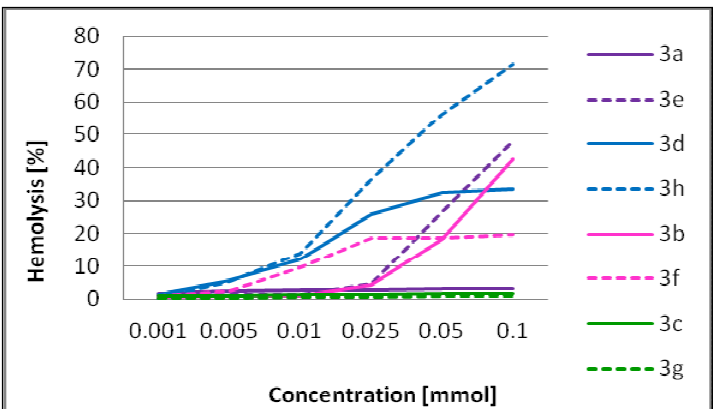
Figure 4. Hemolysis [%] induced by dendrimers on red blood cells suspended in PBS buffer α ( N -series shown as continuous line, N